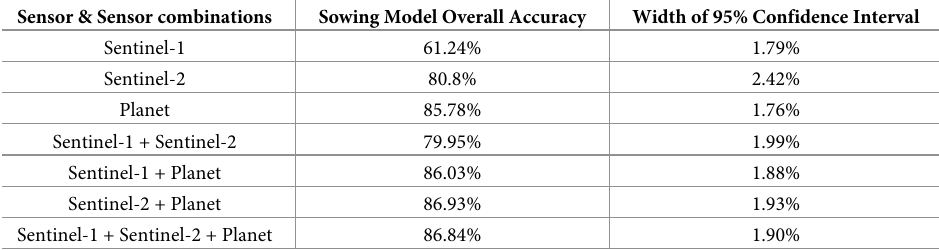
Table 6. Classification results and 95% confidence intervals for single and multiple sensor models for the sowing study period (Oct—Dec). Sensor & Sensor